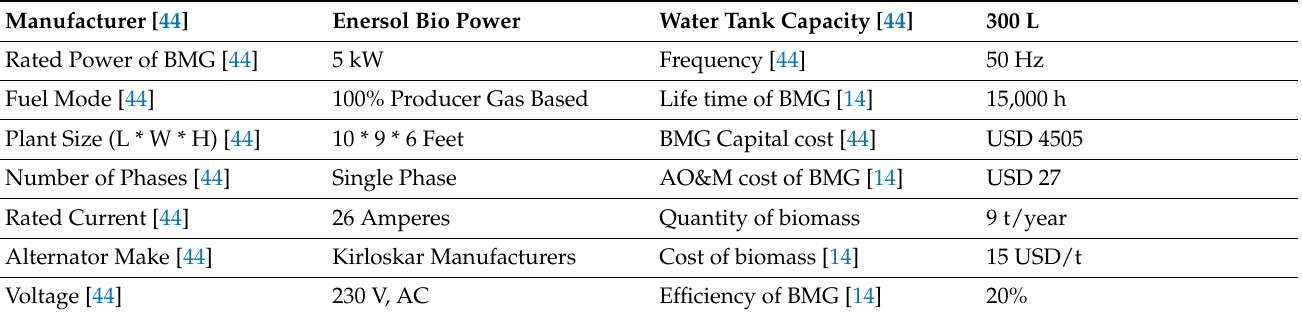
Table 6. Technical and cost values of the biomass generator.